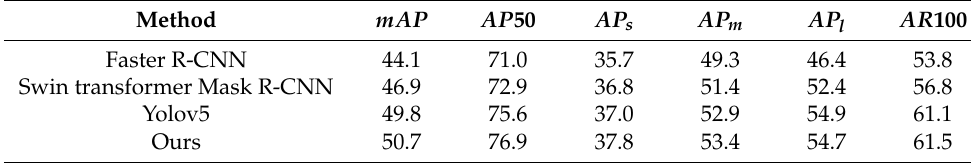
Table 4. Experimental results of each algorithm on the DOTA validation